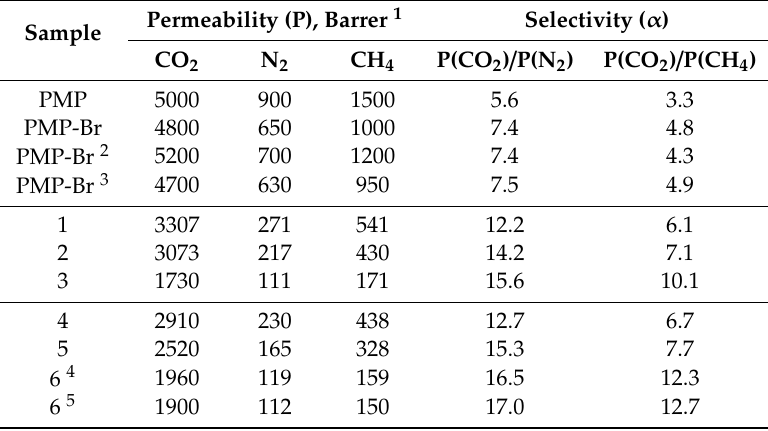
Table 2. Permeability coe ffi cients and ideal selectivities of the initial and modified PMP films toward individual gases.